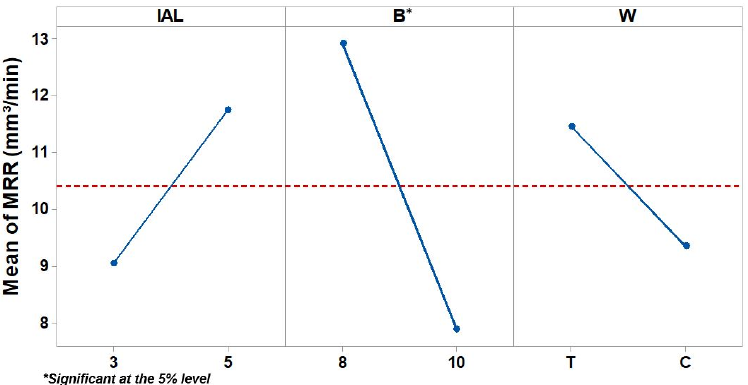
Figure 5. Main effects plot for MRR.